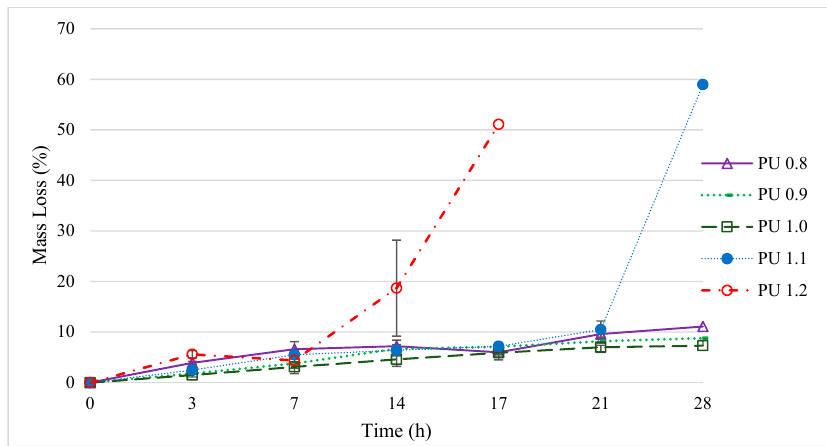
Figure 8. Mass loss of polyurethanes produced by PPP using different isocyanate indices after enzymatic degradation test (Mean ± SD, n = 3). * PU 0.8, PU 0.9, PU 1.0, PU 1.1, PU 1.2 were prepared by reacting palm oil-based polyester polyol with IPDI at isocyanate index of 0.8, 0.9, 1.0, 1.1 and 1.2, respectively.